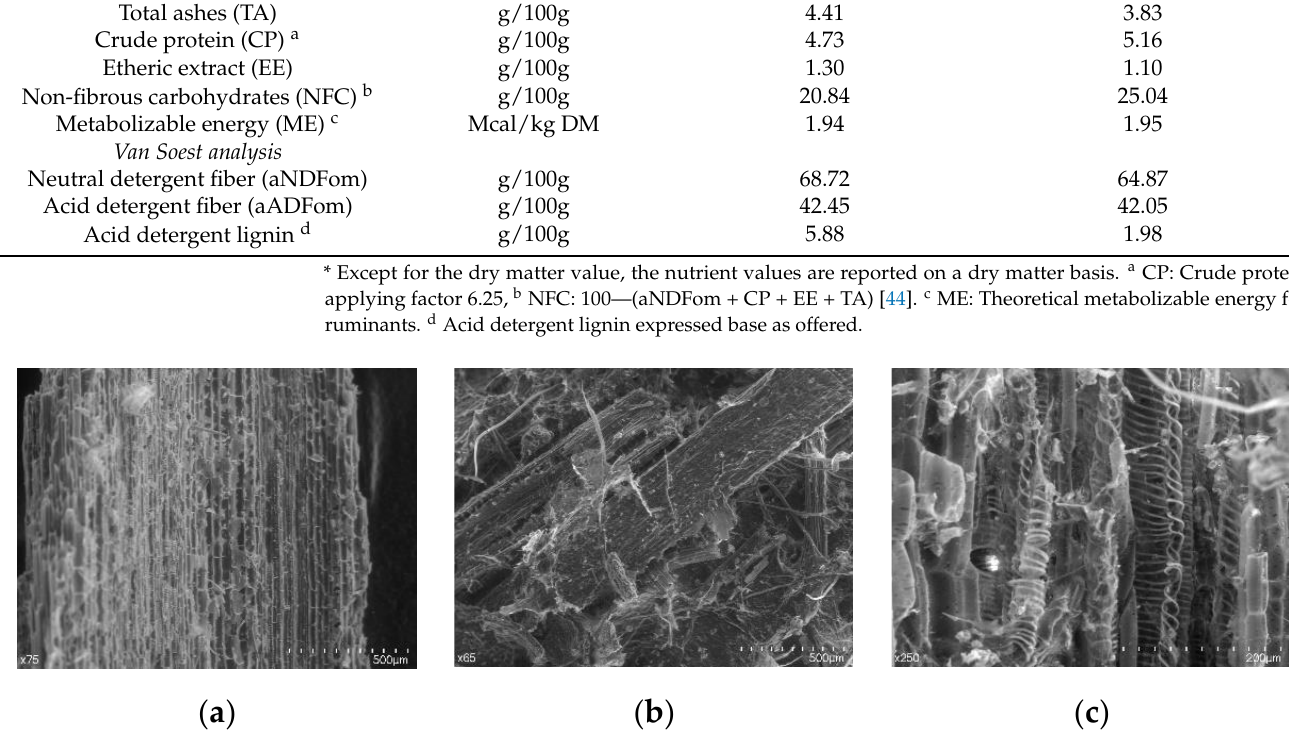
The enzymatic activity (U/L) (Figure 7) varied according to the enzyme type and time. MnP was stable between (6.54 and 7.75 U/L) days 1, 7, 14 and 21, indicating high stability up to 21 days of fermentation. The activity of LiP on day 1 was 14.61, 10.82 on day 7, 19.51 on day 14 and 13.43 U/L on day 21, being statistically the highest on day 14. The enzymatic activity of Lac was highest ( p < 0.05) on day 14, corresponding to 34.17, decreasing later to 30.55 on day 21. Total protein concentration did not differ on days 1, 7 and 14 (varying between 1.1 and 1.2 g/L), and then decreased to 0.760 g/L on day 21 of SSF. Specific enzymatic activity (U/g PT) considers the total protein present in the enzy- matic crude, for MnP, the highest value was reached on day 21 (10.99 U/g PT), doubling the activity measured on days 1, 7 and 14 (varying between 5.83 and 6.55). Similarly, LiP and Lac reached the highest values on 21 days of SSF (18.28 and 40.60, respectively), with fluctuations along the evaluated days (Figure